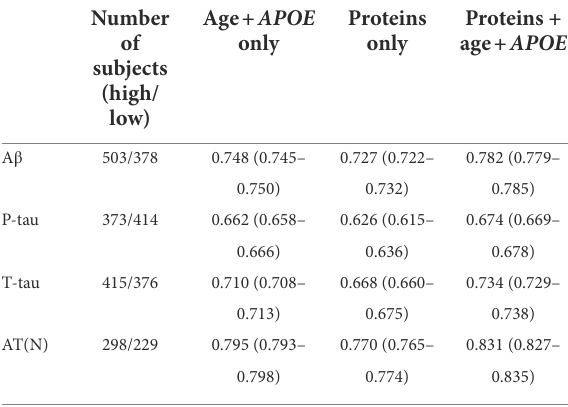
TABLE 2 Summary of AUC scores (95% CI) of NN